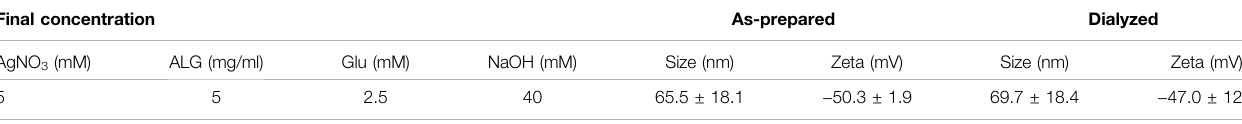
TABLE 1 | The conditions used to synthesize alginate-capped AgNPs as well as particle size, zeta potential ( ζ